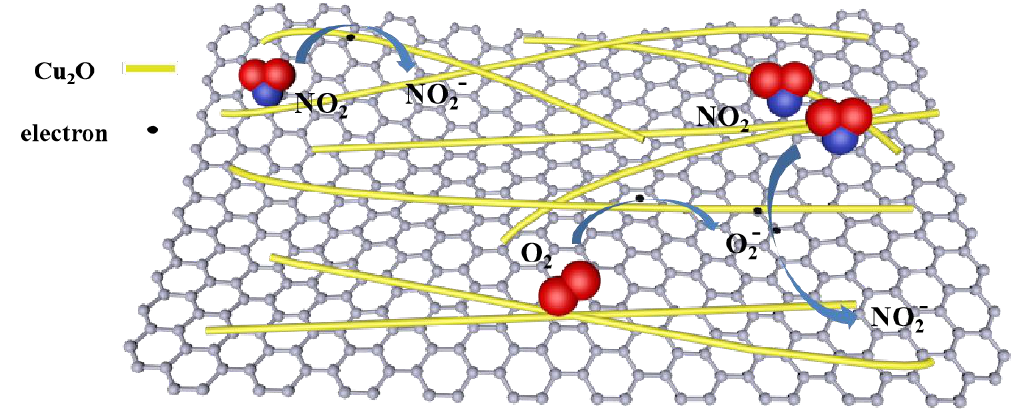
Figure 13. Schematic illustration of the NO 2 sensing mechanism of rGO/PPy/Cu 2 O-based sensor. According to the principle of complementary feedback of gas sensor [64], the com- bination of p-type semiconductors in gas sensors renders a synergistic influence on gas sensing characteristics and temperature coefficients of both materials, reducing zero drift, shortening initial relaxation time, and rendering superior selectivity and stability. Herein, the interdigital electrode is equivalent to the parallel connection of a sensor and several resistors, which reduces the initial resistance of the sensor. The decrease in initial resistance of sensor increased the change in resistance, which corresponds to the response value. Dur- ing the recovery stage of gas sensor, the newly adsorbed air molecules eliminate